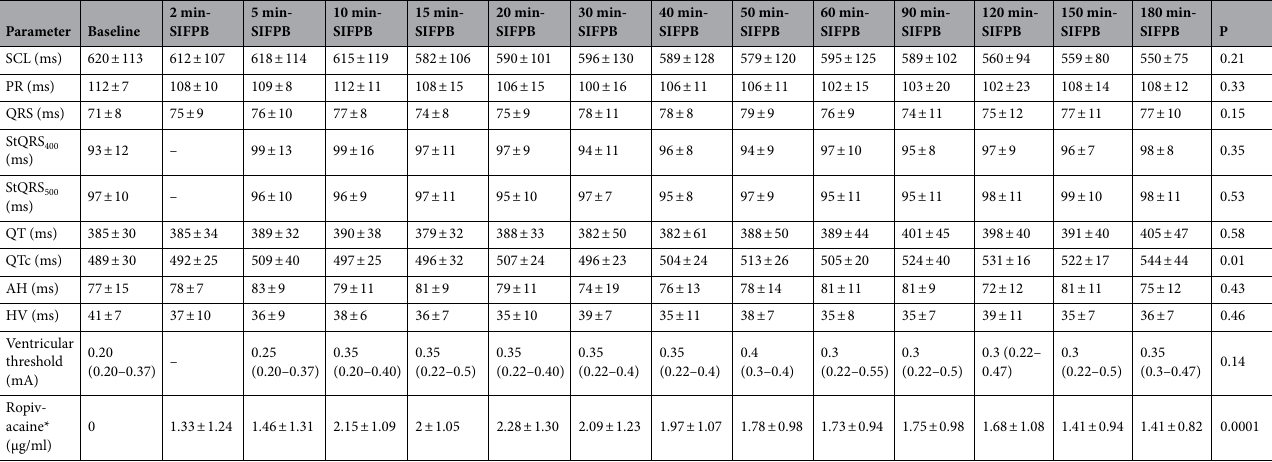
Table 2. Electrophysiological variables on the baseline and 2, 5, 10, 15, 20, 30, 40, 50, 60, 90, 120, 150 and 180 minutes after serratus intercostal fascial plane block. Data are shown as medians and interquartile range (IQR) for non-normally distributed data using the Shapiro–Wilk test, and as means ± standard deviation for normally distributed variables. SIFPB serratus intercostal fascial plane block, SCL sinus cycle length, PR PR interval, QRS QRS duration, St QRS 400 duration of stimulated QRS at a paced cycle length of 400 ms, St QRS 500 duration of stimulated QRS at a paced cycle length of 500 ms, QTc corrected QT interval, AH atrial His interval, HV His- ventricular interval. *Arterial ropivacaine concentrations.